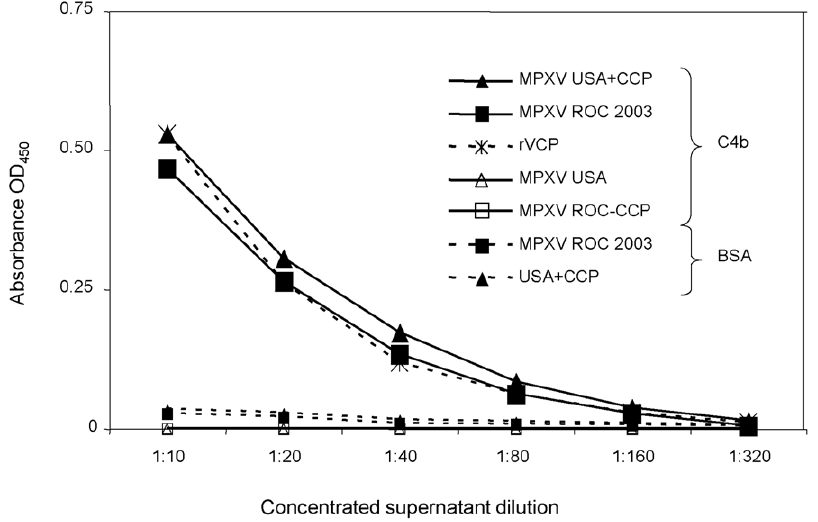
Figure 3. C4b binding activity of monkeypox virus CCP. Assay measuring the binding of MPXV complement control proteins from the media of infected cells to human C4b. Solid triangles and squares show binding activity of USA + CCP and ROC 2003, respectively, to C4b (solid lines) or to control wells with BSA alone (dashed lines). Open triangles and squares show binding activity of USA and ROC D CCP, respectively, to C4b. Also graphed is a known concentration of rVCP (star symbol with dashed line) from which we estimated the amount of MPXV CCP in the media of infected cells. The starting amount of rVCP was 2.5 ng (1.75 nM) and was then similarly diluted 2-fold. The error bars in this figure were smaller than the symbols.